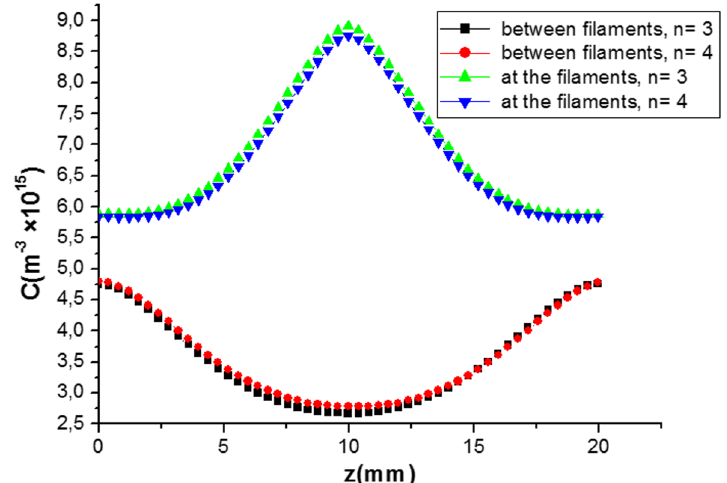
Fig. 5 Distribution of concentration of CH 3 as function of z ; at the filaments and between the